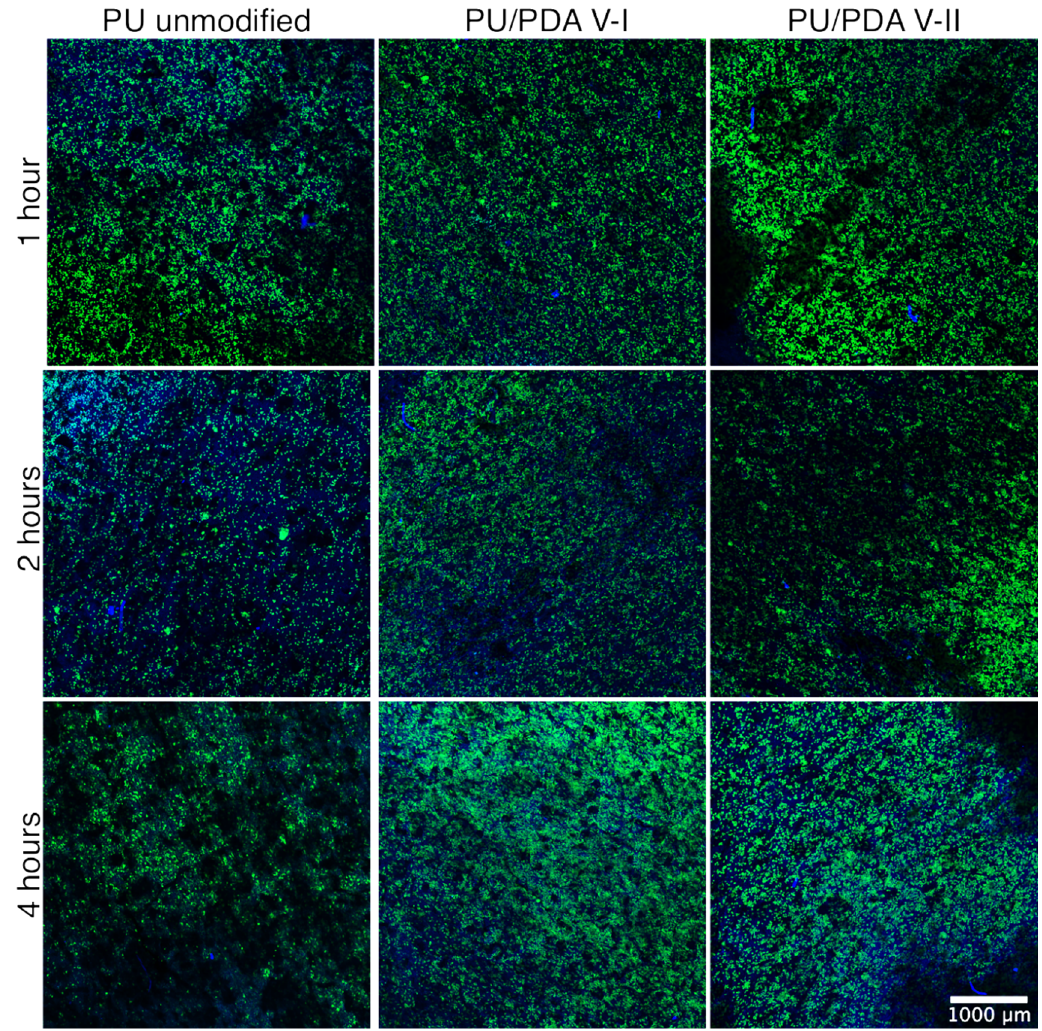
Figure 10. Confocal laser scanning microscope wide-view images of L929 cells attachment on the surface of PU unmodified PU and PDA-modified (VI—8 h of the modification, VII—0.5 h of modification) nanofibrous materials after 1, 2, and 4 h of cells incubation.